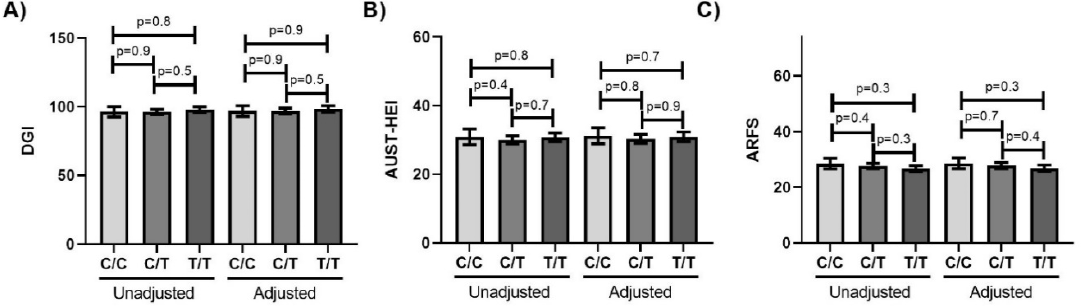
Figure 2. Diet quality indices do not vary by TRPV1-rs8065080 genotype. ( A ) DGI ( B ) AUST-HEI ( C ) ARFS. Error bars mark 95% confidence intervals. Unadjusted present mean values with no adjustments. Adjusted present Least-squares means with adjustments for sex, education and smoking.